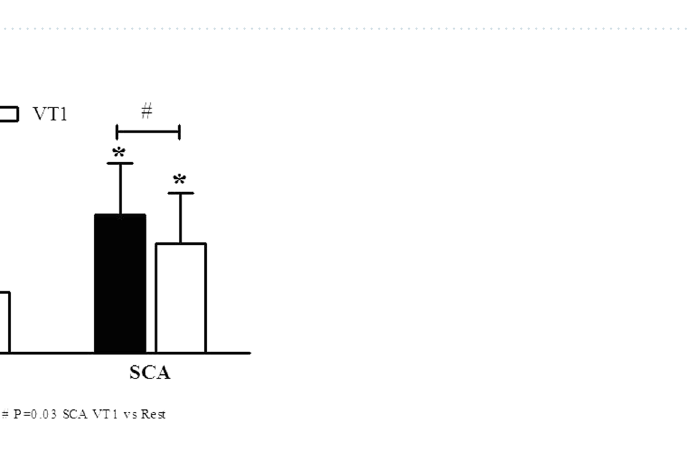
Figure 4. Exercise reduced RBC Nitrite/RSNO/Fe-NO concentration in SCA patients. RBC Nitrite/RSNO/ Fe-NO levels were significantly higher in SCA compared to healthy controls (AA) at Rest. Significantly decreased Nitrite/RSNO/Fe-NO concentrations were measured in SCA after exercise (VT 1) while levels in AA remained unaffected. Data are mean ± s.d. of n = 8 AA and n = 8